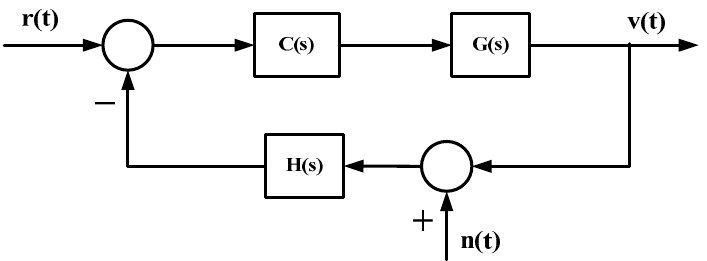
Figure 2. Schematic diagram of the control system structure.